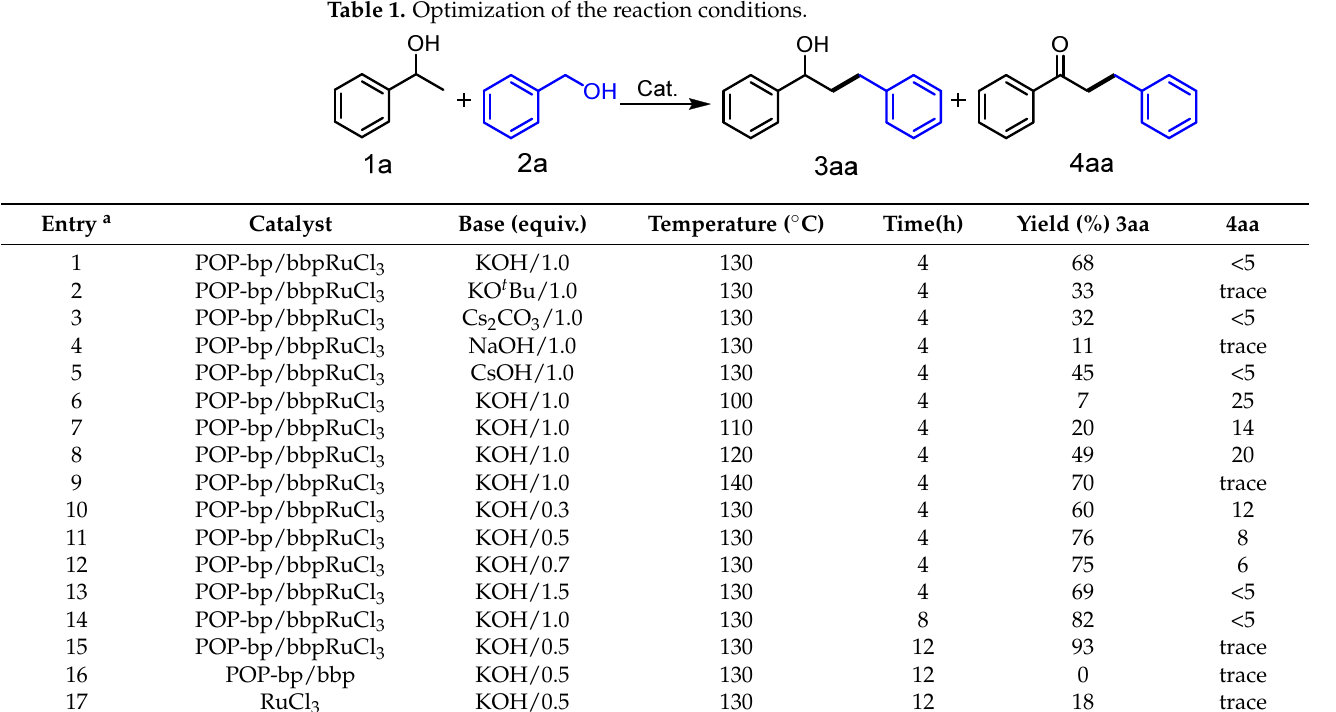
Table 1. Optimization of the reaction conditions.